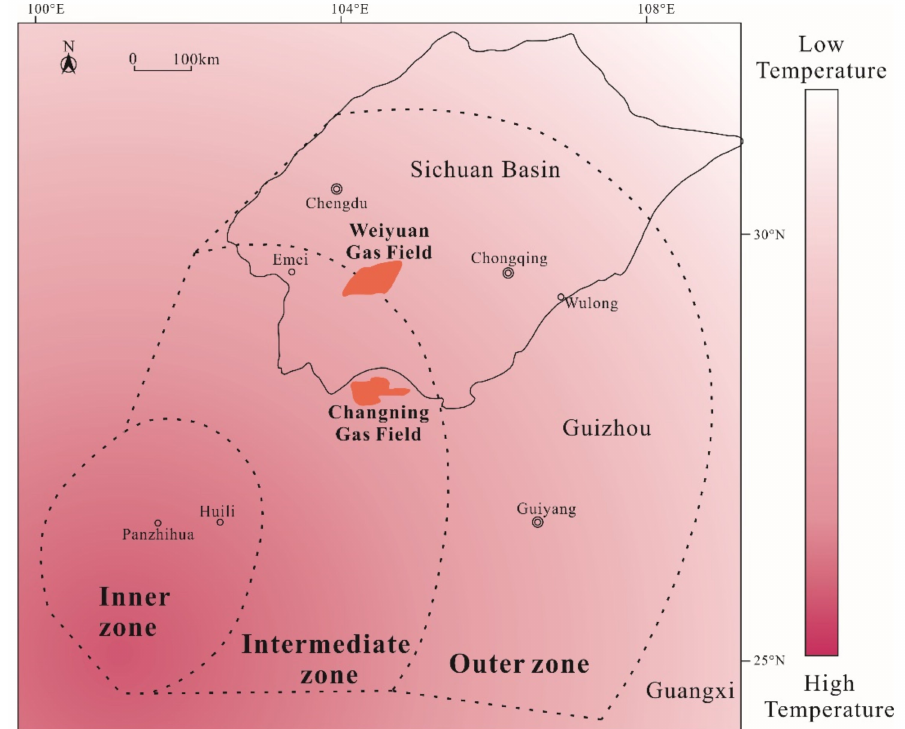
Figure 3. Schematic map of the Emeishan large igneous province (ELIP) and its thermal e ff ect (Jiang, 2017, modified from Sun et al., 2010). The dashed lines show the boundaries of the inner, intermediate, and outer zones of the ELIP, as defined by He et al. (2003). For the interpretation of the references for color in this figure legend, the reader is referred to the web version of this article. The red column represents the Permian heat flow and the green column represents the present heat